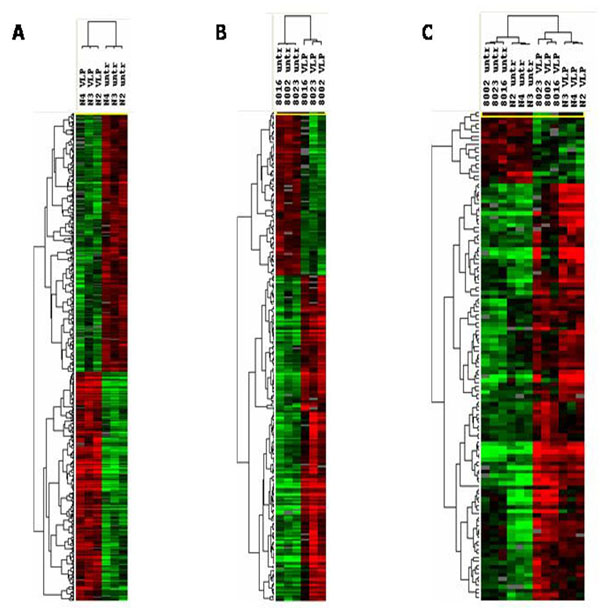
Supervised hierarchical clustering of genes differentially expressed in HIV-VLP-treated cells. The clusterograms represent an Eisen hierarchical clustering of genes differentially expressed (p< 0.005) in HIV-VLPs-treated PBMCs (A), MDDCs (B). The comparison between the two cell populations is shown in C. The clustering is defined by the dendrogram on the top of the clusterogram.